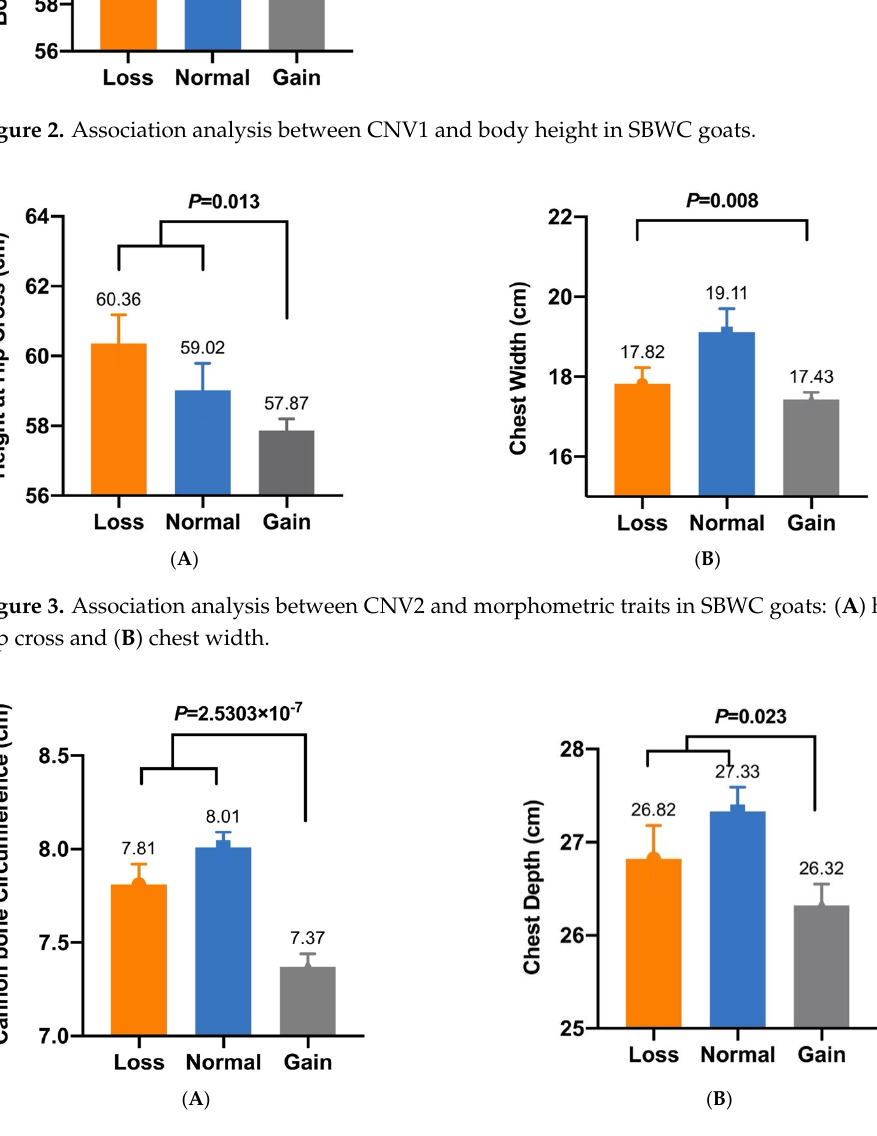
Figure 5. Association analysis between CNV4 and body length in SBWC goats. ( A )